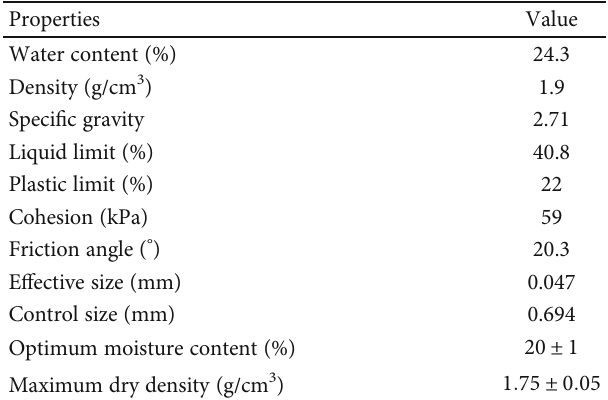
Table 1: Physical properties of reticulate red